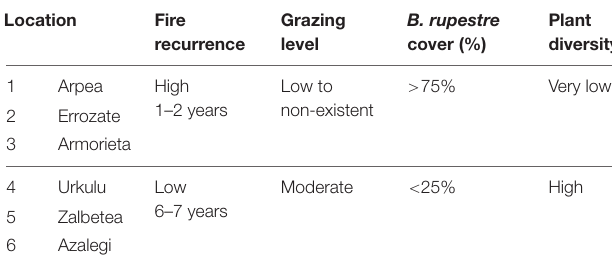
TABLE 1 | Characteristics of the six locations